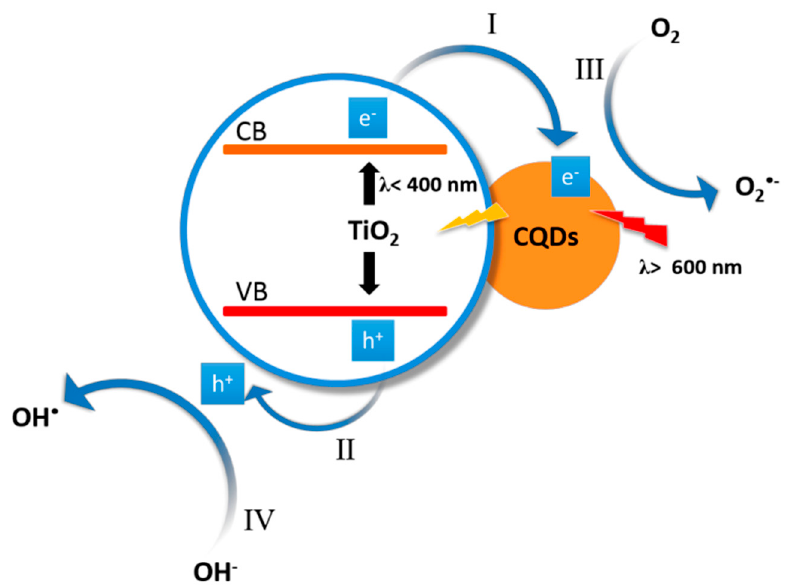
Figure 3. The involved phenomena and mechanisms linked to the photocatalytic activity of compo- site of TiO 2 with carbon quantum dots (CQDs) under visible light irradiation. Reprinted with permission from Ref. [93]. Copyright 2016, Elsevier.